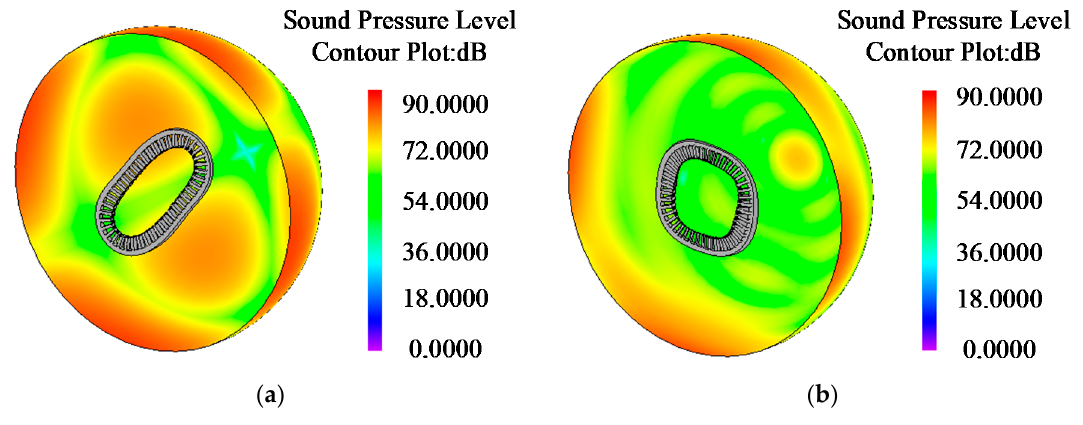
Figure 9. Acoustic noise image: ( a ) 800 Hz; ( b ) 1800 Hz.